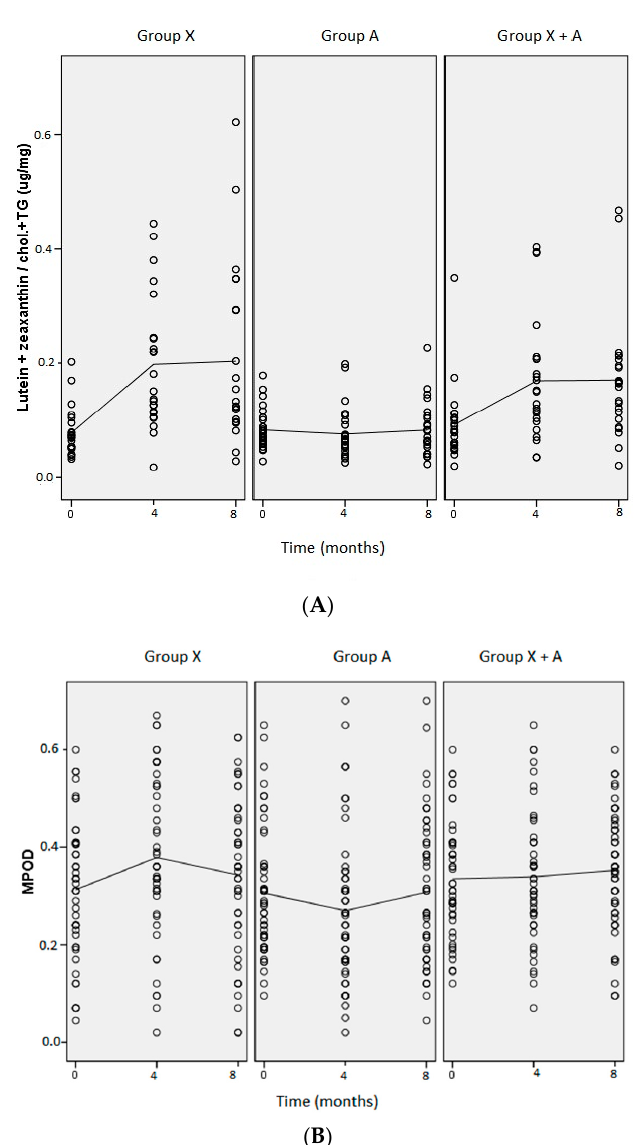
Figure 1. Concentrations of L+Z /chol. + TG in serum ( A ) and MPOD units ( B ) in each group of treatment at baseline, and after 4 and 8 months of the study.